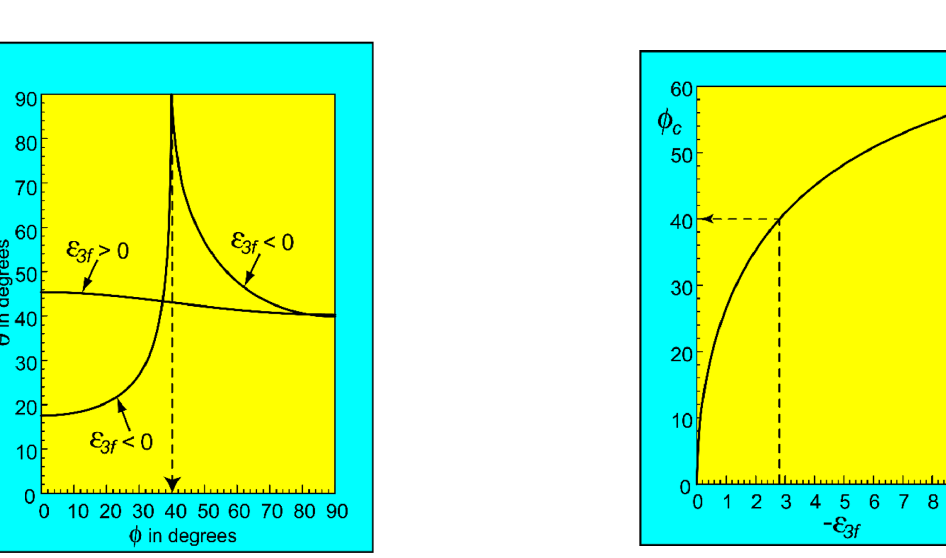
Figure 5. The figure demonstrates the increasing range in h over which homogeneous waves occur in a hyperbolic film with e 3 f < 0, as / increases towards a certain critical value. The dark blue areas show the regions over which pure hybrid homogeneous guided wave are possible.